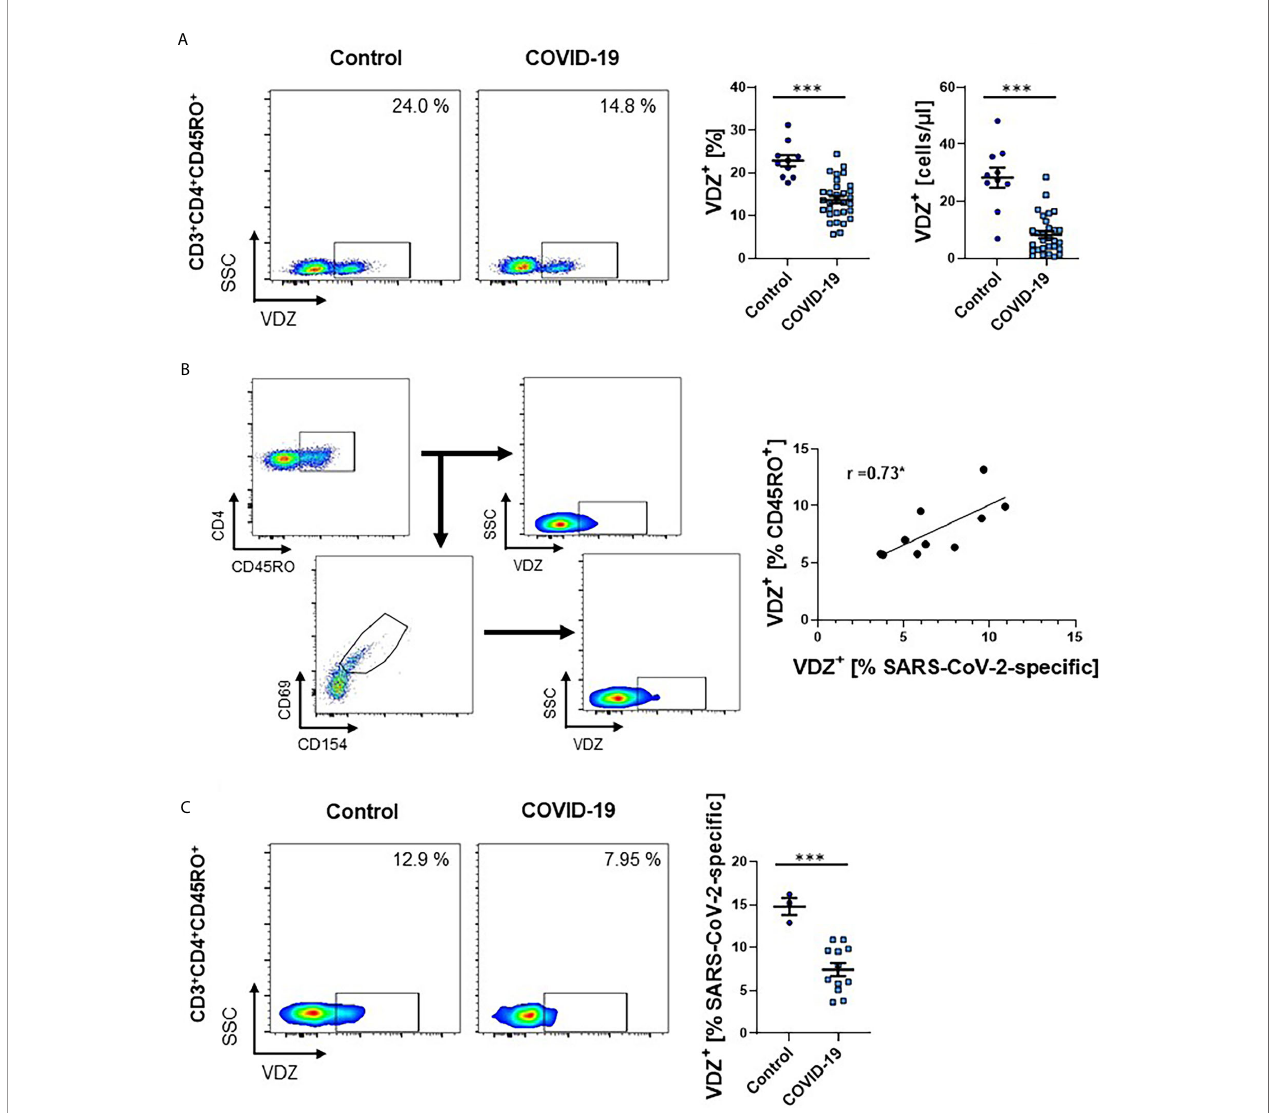
FIGURE 2 | Frequency of VDZ + CD4 + memory T cells during COVID-19. (A) Representative (left) and quantitative (right) fl ow cytometry of whole blood samples of COVID-19 patients and healthy controls. Graphs indicate the frequency and absolute cell numbers of CD3 + CD4 + CD45RO + memory T cells staining positive for the anti- a 4 b 7 integrin antibody VDZ. n = 10-31. (B) Exemplary gating strategy (left) and correlation (right) of a 4 b 7 (VDZ) expression on SARS-CoV-2-speci fi c CD3 + CD4 + CD45RO + memory T cells to a 4 b 7 (VDZ) expression on overall CD3 + CD4 + CD45RO + memory T cells from patients with COVID-19. Spearman ’ s r is indicated. n = 10. (C) Representative (left) and quantitative (right) fl ow cytometry of the frequency of a 4 b 7 (VDZ) expression on SARS-CoV-2-speci fi c CD3 + CD4 + CD45RO + memory T cells of COVID-19 patients and healthy controls. VDZ, vedolizumab. Each symbol represents an individual subject, n = 3 -12 per group. ***p <